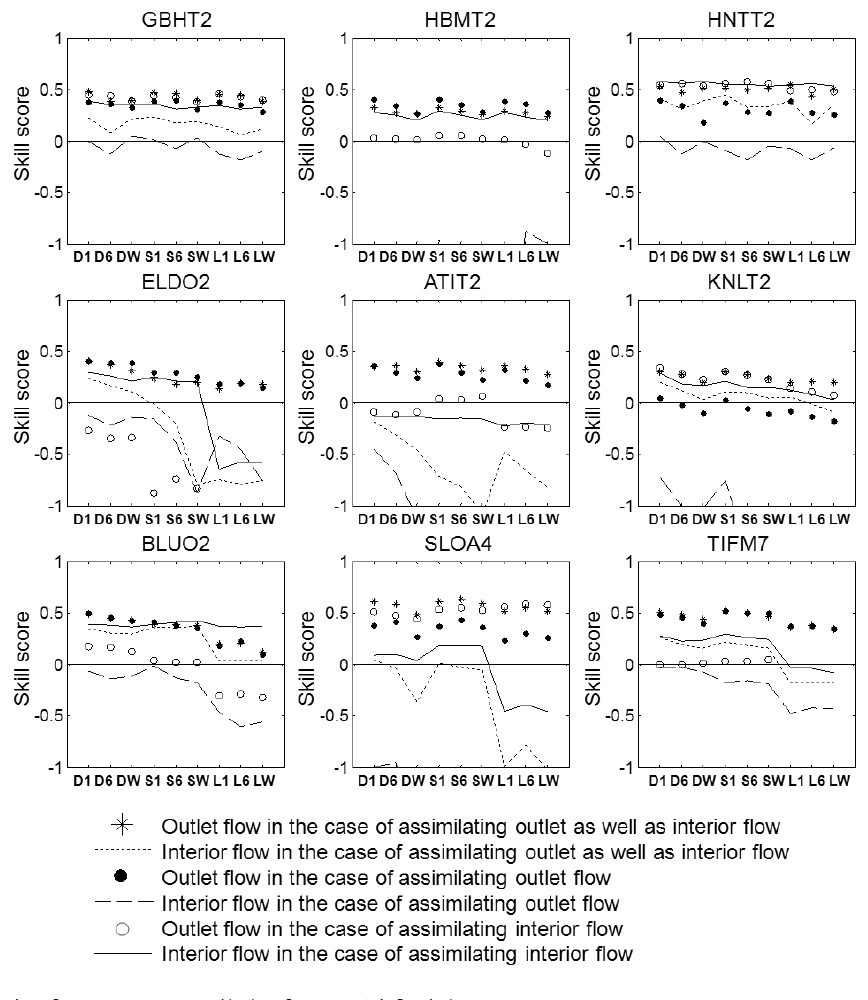
Fig 6. Same as Fig 5 but for streamflow prediction for 1- to 6-hr lead time. 823 Fig. 6. Same as Fig. 5, but for streamflow prediction for 1- to 6-h lead